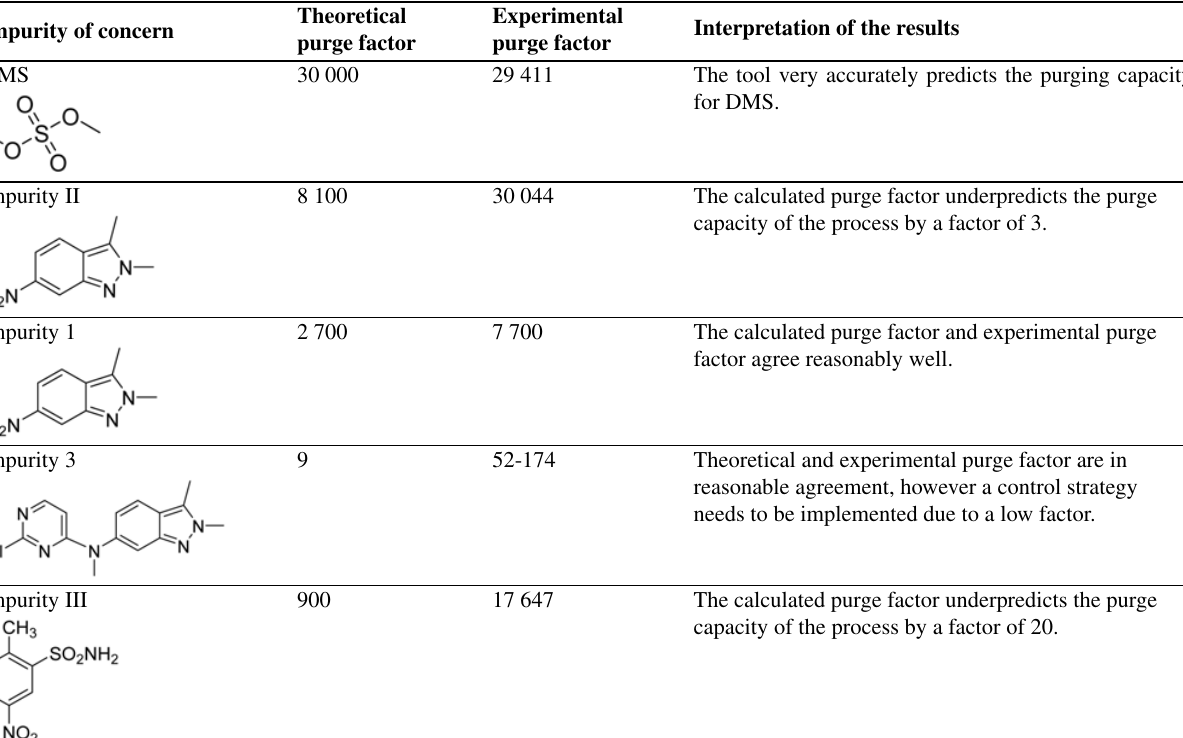
Table 5. Summarized results of the case study for the synthesis of pazopanib hydrochloride (based on Elder et al. 31 ). Impurity of